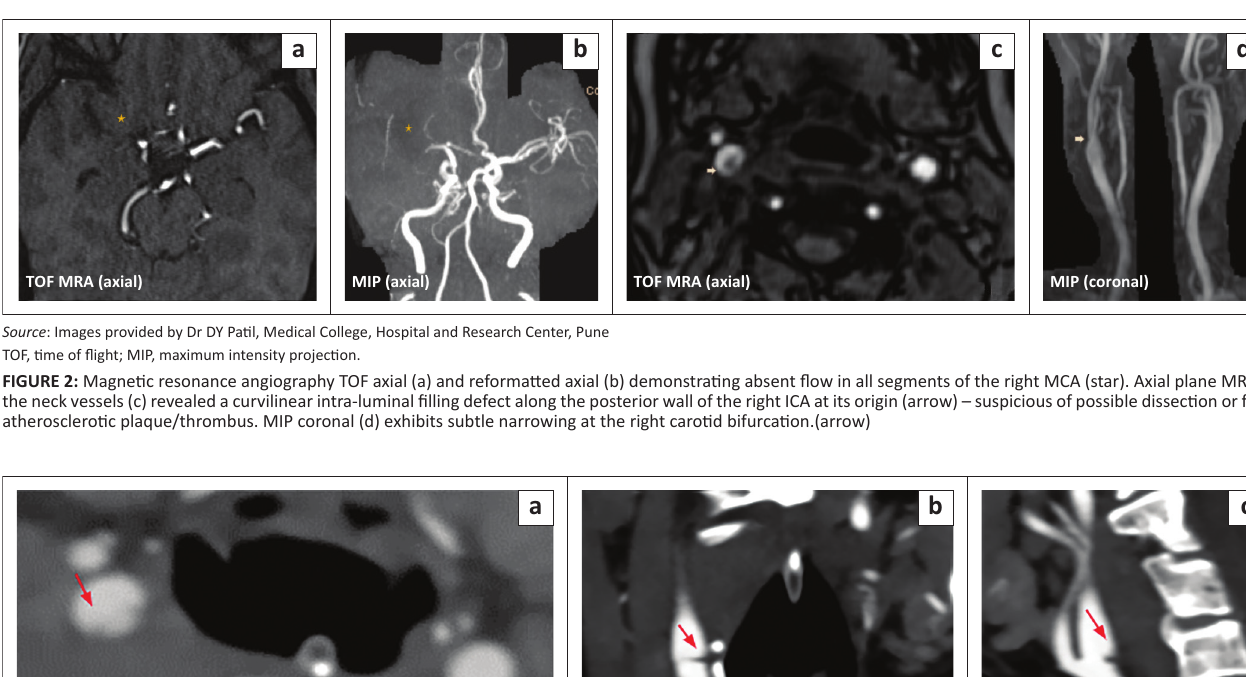
FIGURE 1 : (a) NCCT brain illustrating an ill-defined hypodense infarcted area in the right fronto-parieto-temporal region, with loss of the insular ribbon and effacement of the adjacent sulci and right sylvian cistern. (b) MRI brain revealed a FLAIR hyperintense acute non-haemorrhagic infarct in the right MCA territory. DWI (c) and ADC (d) shows diffusion restriction with corresponding low ADC values.